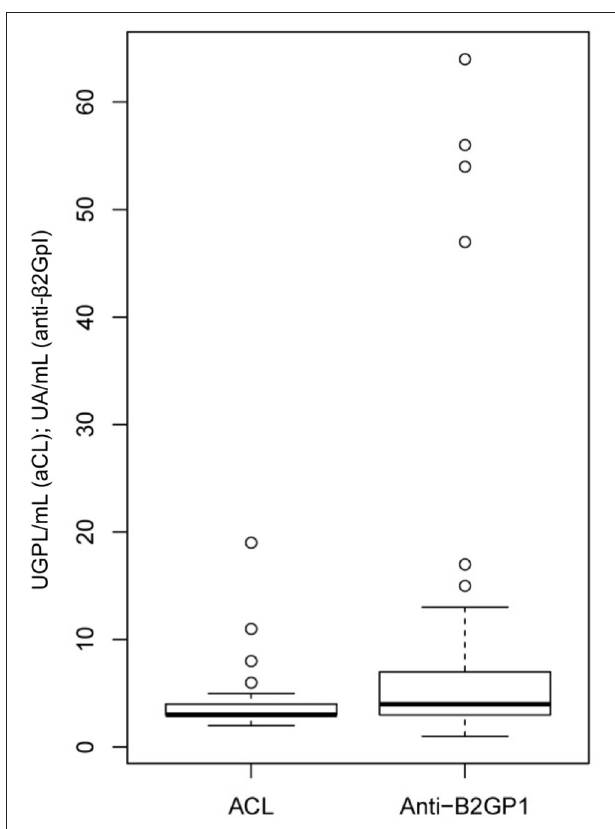
FIGURE 1 | Titers of aCL and anti- β 2GpI in this cross-sectional study of SSc